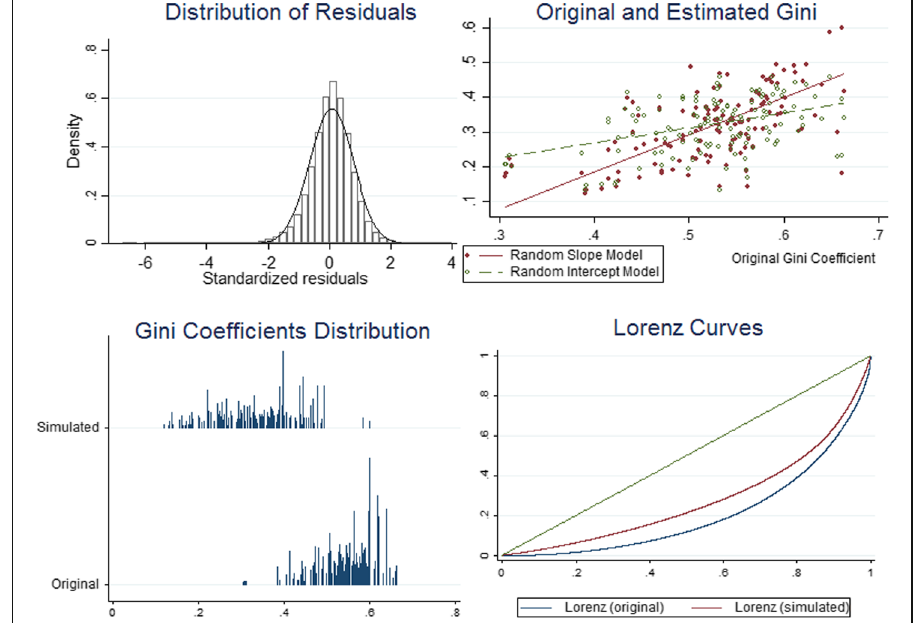
Fig. 1 Model check and simulation based on random slope model. Notes. Figure in the top right shows distribution of residuals from random slop model. Top right shows correlation between original Gini and predicated Gini based on model 3 ( dashed line ) and model 4 ( solid line ). Figure in the bottom left shows distribution of original Gini and simulated Gini based on Model 4. Bottom right shows Lorenz curves generated by original and simulated Gini (based on Model